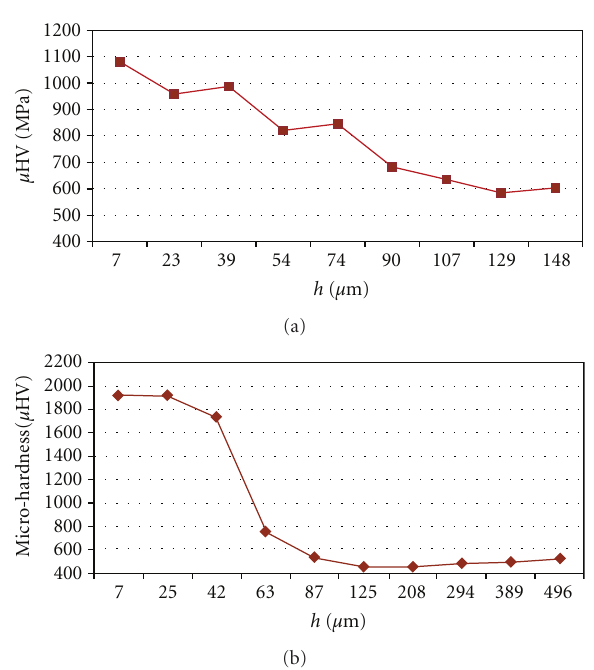
Figure 12: (a) Microhardness versus the distance from the edge for the specimen machined by the tungsten electrode at the following parameters. (a) EDA I = 24 (A), Ti = 400 ( μ s), (b) EDA I = 24 (A). Ti = 400 ( μ s) and then the roto-peen n = 4100 (rev/min), t = 75 (s).